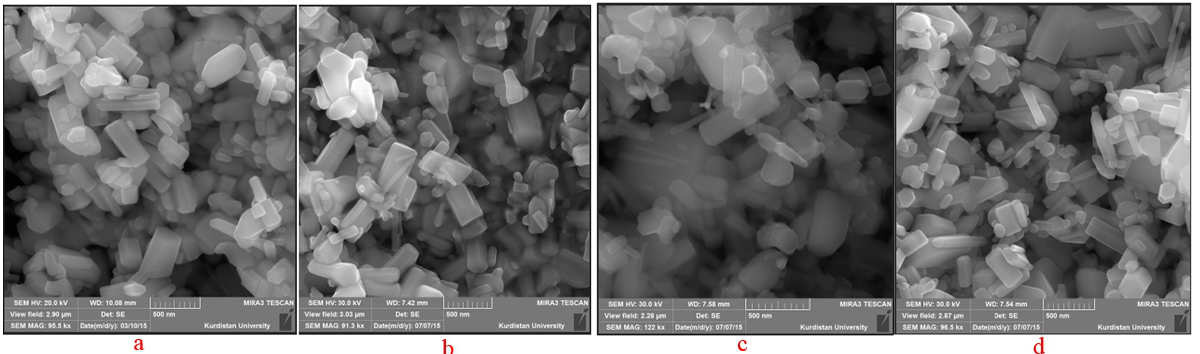
Fig. 1. SEM Images of nanoparticles a) ZnO b) WO-ZnO 0.5% c) WO-ZnO 1% d) WO-ZnO